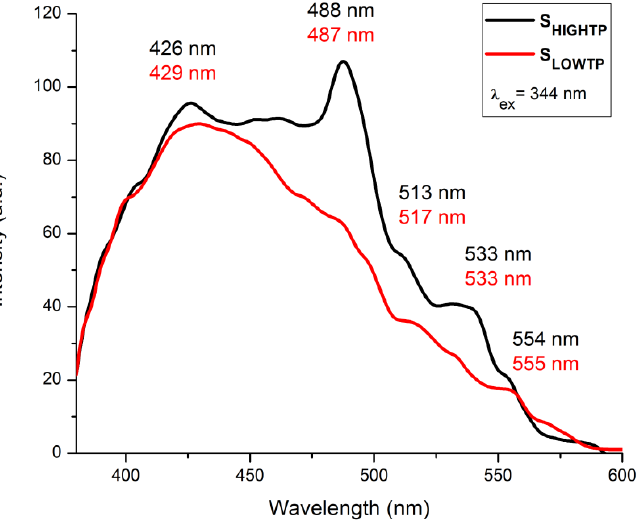
Figure 10. Fluorescence emission spectra obtained at RT for S LowTP and S HighTP in the 380–600 nm range, excitation at 344 nm.